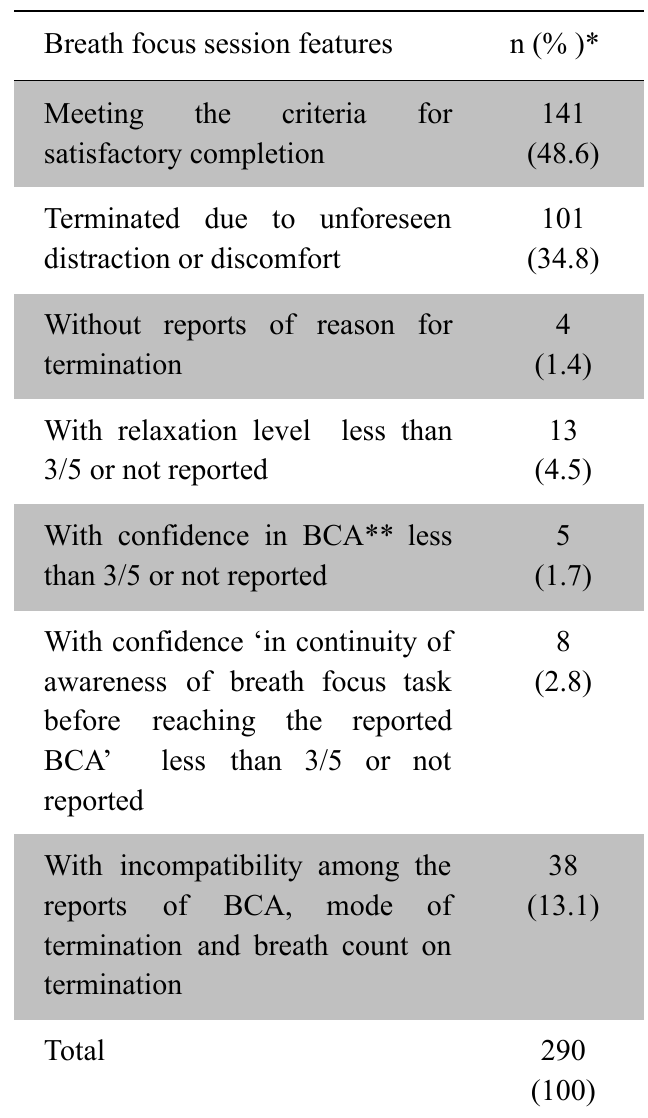
Table 1: Baseline characteristics of the participants